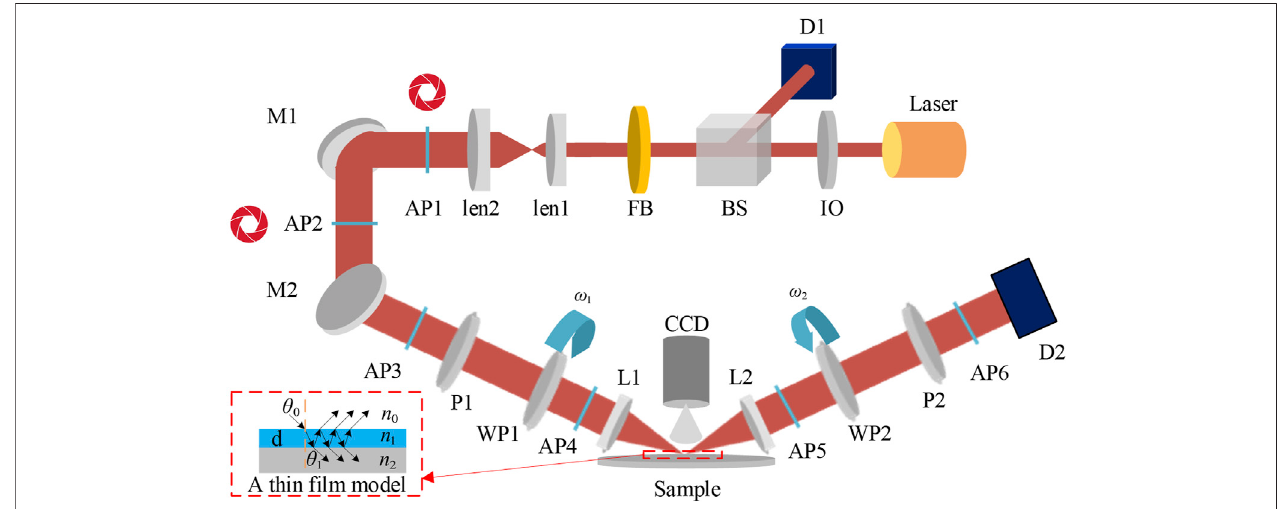
FIGURE 1 | Critical components and beam path of the SWE. The ellipsometer is composed of a He – Ne laser light source (He – Ne laser), an optical isolator (IO), a beamsplitter(BS),twodetectors(D1andD2),anarrowband fi lter(FB),abeamexpander(BE)(GBE-03A,Thorlabs,UnitedStates),sixapertures(AP1-AP6)(SM1D12CZ, Thorlabs, United States), two mirrors (M1 and M2), two polarizers (P1 and P2)(LPVISC100-MP2, Thorlabs, United States), two continuously rotating wave plates (WP1 andWP2)(WPQ10M-633,Thorlabs,UnitedStates),twofocuslenses(L1andL2),andaCCDcamera(Mer-503-20GM-P,DAHENG,China).Incidentandre fl ected beams are denoted in red.